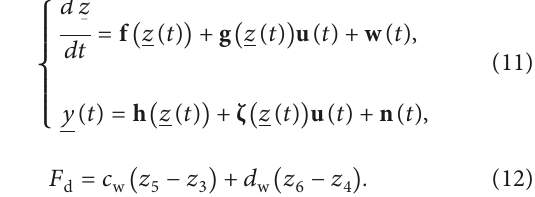
by mass of the car m s